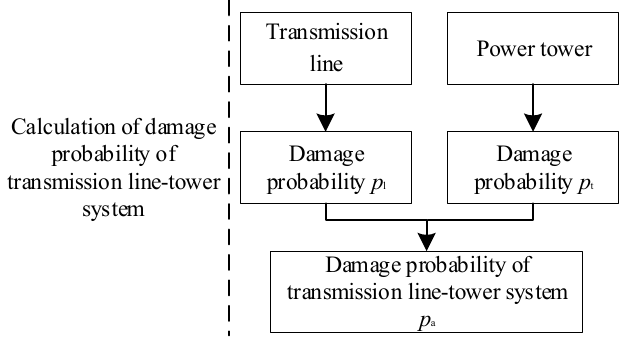
Figure 3. Damage prediction flow chart of the transmission line-tower system. 259